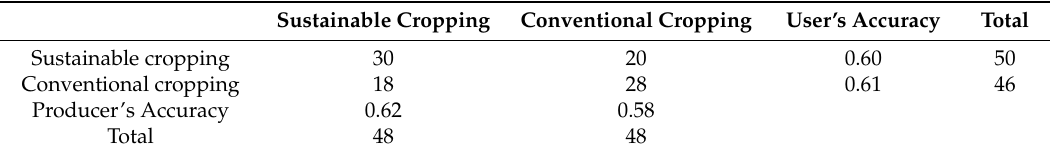
Table 2. Confusion matrix for neural network model trained to discriminate two cropping